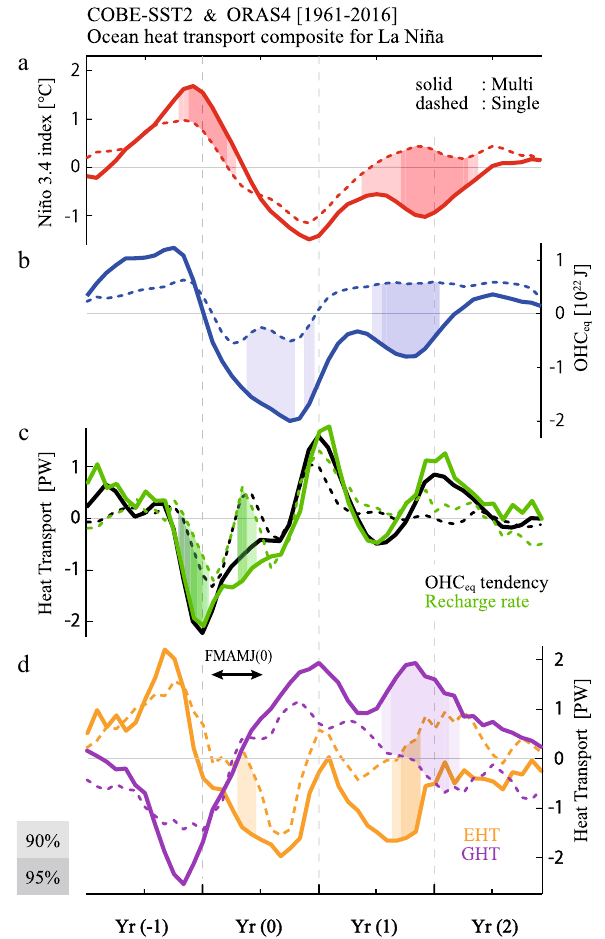
Figure 2. Time evolution of multi-year and single-year La Niña and associated recharge processes. Time series of composited multi-year (solid curves) and single-year (dashed curves) La Niña events for ( a ) N3.4 and ( b ) OHC eq anomalies; ( c ) OHC eq tendency (black) and its reconstruction by the recharge rate (green) (Methods); and ( d ) contribution to the recharge rate by the geostrophic term (GHT, purple) and the Ekman term (EHT, orange). Shadings indicate the difference between multi-year and single-year composites statistically significant at the 90 and 95% confidence levels. The time series are smoothed with a three-month running mean after the individual budget term was